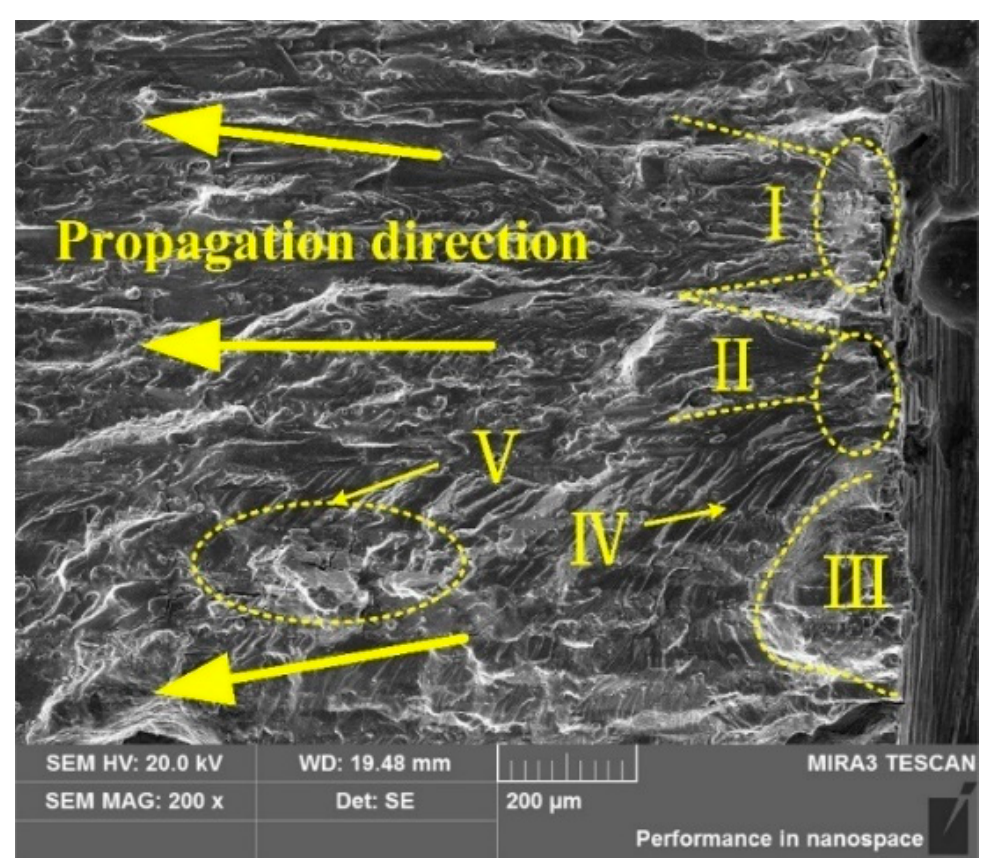
Figure 6. SEM micro-morphologies of fatigue source area.